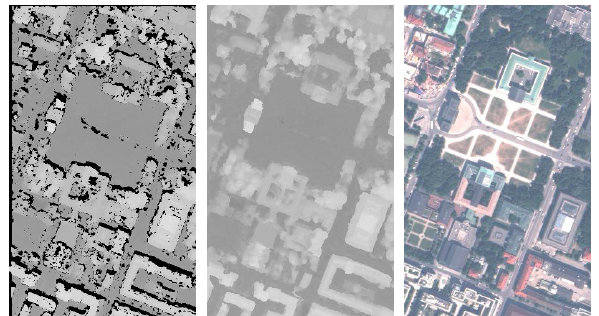
Figure 3. Height map fitting on first pan image, corrected height map, pan-sharpened first image (l.t.r.), 300 m × 500 m each